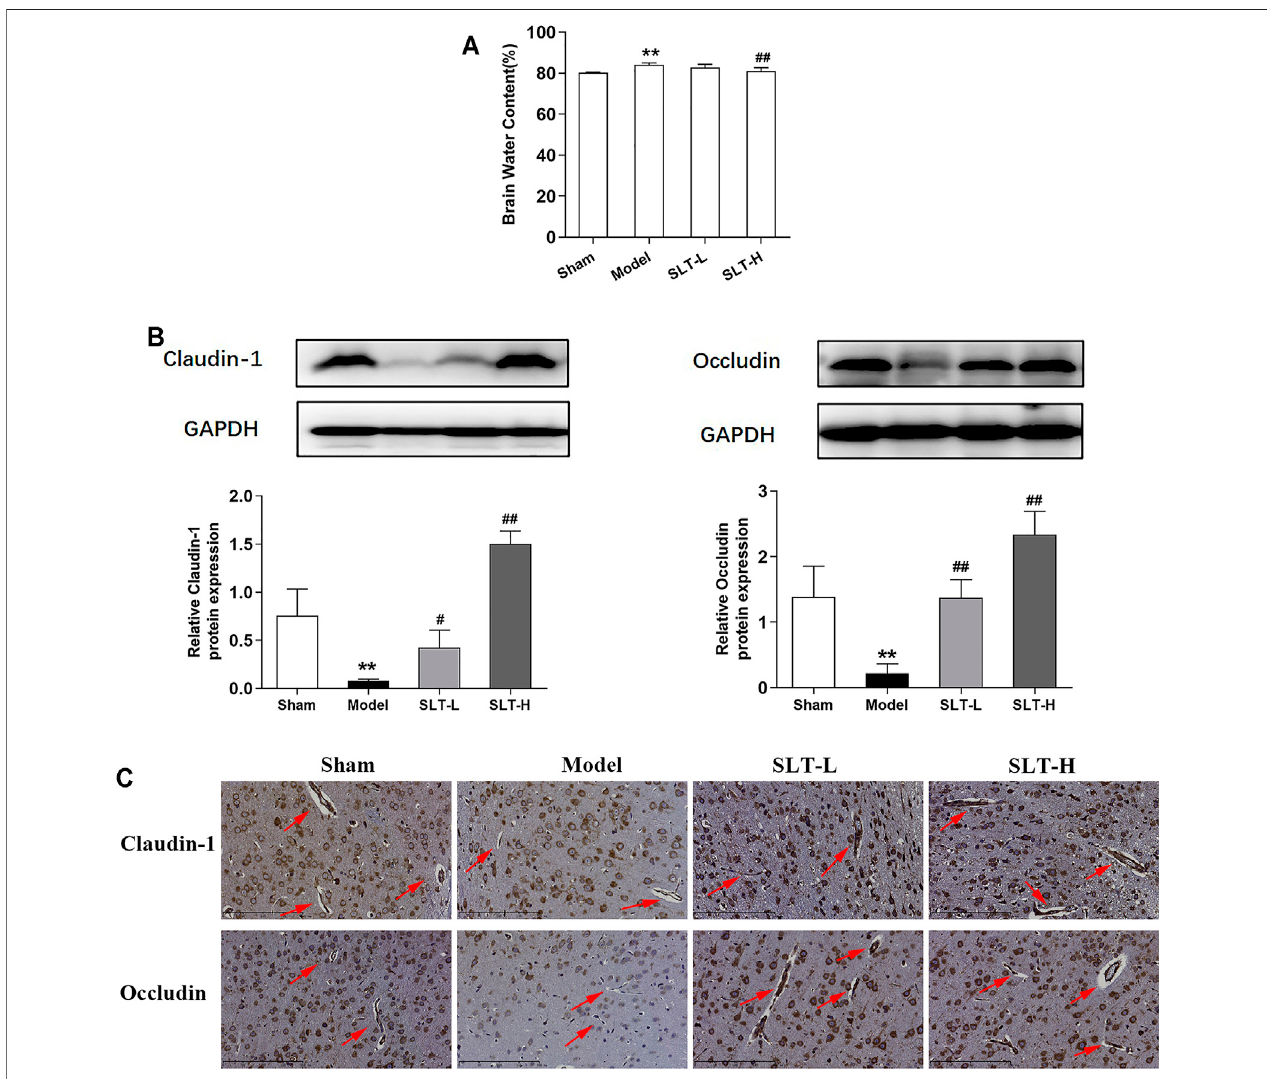
FIGURE 2 | SLT decreased brain edema and prevented the loss of tight junction proteins in the cerebral vascular endothelium in MCAO rats. (A) Brain water contents of the ischemic hemispheres measured by the wet and dry weight method ( n (cid:1) 7). (B) Western blot assays for claudin-1 and occludin expressions in the ischemichemispheres( n (cid:1) 3). (C) Representativeimagesofimmunohistochemistryexaminationforclaudin-1andoccludinintheischemiaareas.Thearrowspointtothe blood vessels (scale bar (cid:1) 200 μ m). Data are represented as mean ± SD. * p < 0.05, ** p < 0.01, compared with the sham group; # p < 0.05, ## p < 0.01, compared with the model